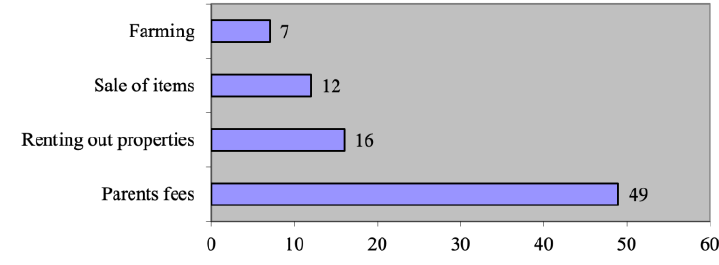
Figure 1: Sources of Revenue identified by Parents; Source: Field Data